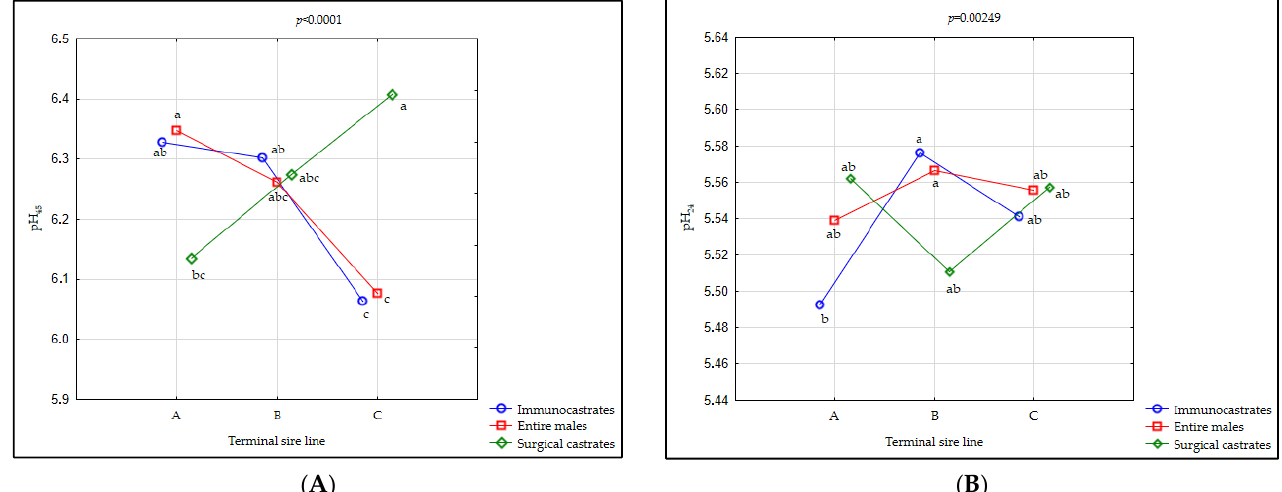
Figure 2. The interaction between immunocastrates (IC), entire males (EM) and surgical castrates (SC) originating from different terminal sire lines. ( A ) and pH 24 in LD muscle ( B ). Terminal sire line A = Pietrain × Large White; Terminal sire line B = pure Pietrain; Terminal sire line C= Pietrain × Duroc × Large White. Significant differences ( p < 0.05) between groups are denoted by different lowercase letters (a, b, c).